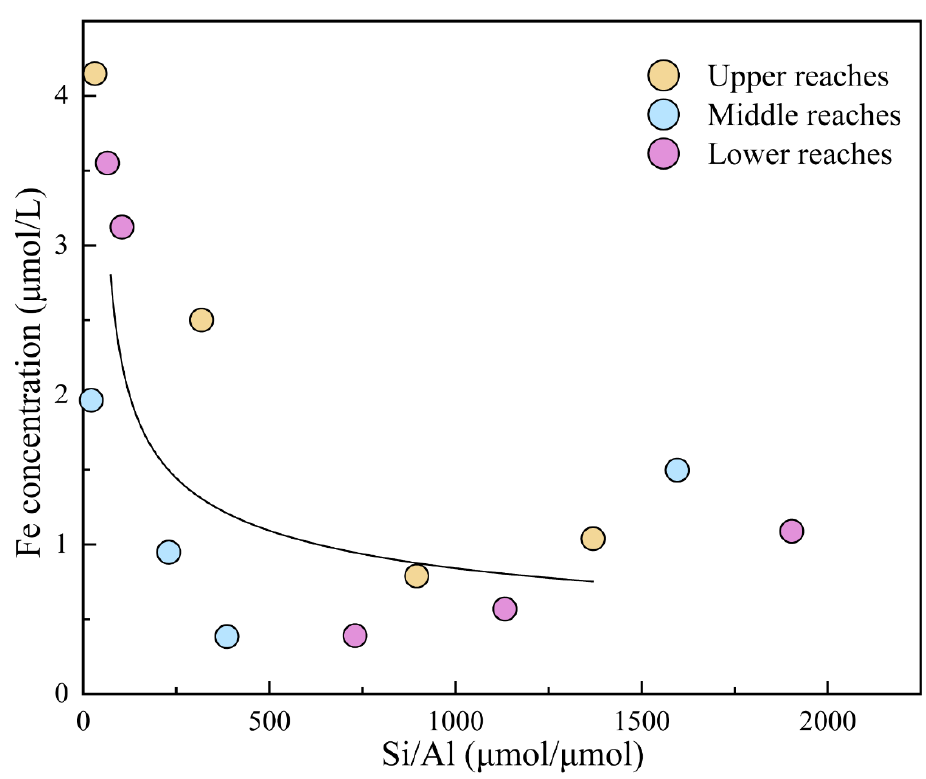
Figure 5. Fe concentration ( µ mol/L) versus Si/Al ratio ( µ mol/ µ mol) in MR water in the dry season. The data of Si are from [53] .